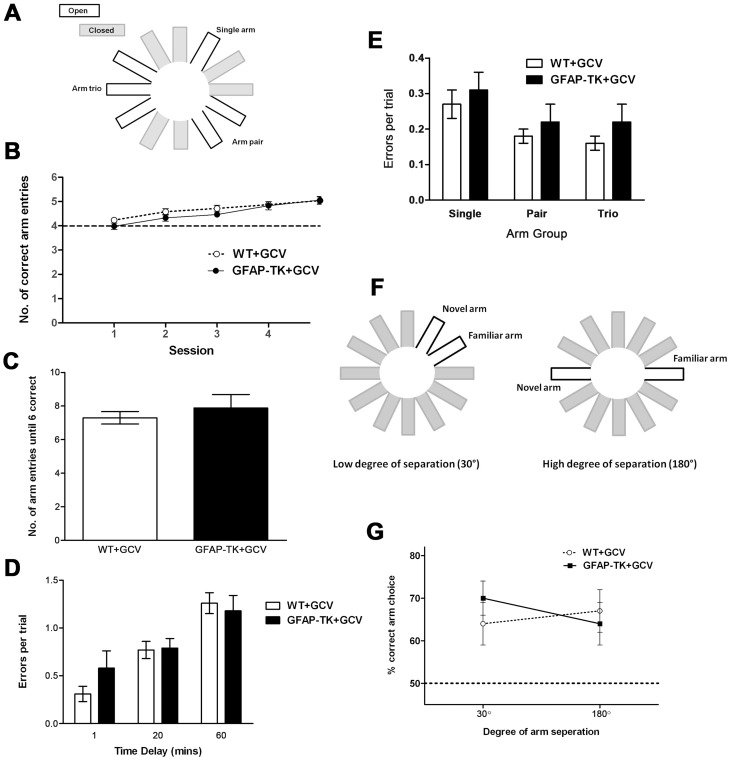
Ablating adult neurogenesis does not affect spatial working memory in the radial maze.
A Arm configuration for radial maze task. B Mean number (± sem) of correct arm entries made during a maximum of 6 entries per trial, by GCV-treated wild type (n = 13) and GFAP-TK (n = 13) rats. C Number of arm entries made before all 6 arms had been visited in a trial, by GCV-treated wild type (n = 13) and GFAP-TK (n = 11) rats. The mean score (± sem) is shown for four sessions (4 trials per session). D Rats made 3 initial arm choices, followed by a 1, 20 or 60 minute delay, followed by 3 final arm choices. Data show the number of errors made during the final 3 arm choices, by GCV-treated WT (n = 13) and GFAP-TK (n = 11) rats. Each data point represents the mean score (± sem) for 3 trials for each rat. E Number of errors made per trial into the single arm, pair of arms and arm trio, by GCV-treated wild type (n = 13) and GFAP-TK (n = 11) rats. Data are adjusted according to the number of arms in each group (e.g. total number of arm entries into the trio was divided by 3). Each data point represents the mean score (± sem) per trial. F Arm configuration for the binary choice delayed non-matching to place radial maze task. G The percentage of trials (± sem) in which the novel arm was correctly chosen, by GCV-treated wild type (n = 11) and GFAP-TK (n = 9) rats in the delayed non-matching to place task. Wild type data are represented by an open circle connected by an interrupted line, GFAP-TK data are represented by filled squares and a solid line. The interrupted horizontal line represents chance levels of performance.